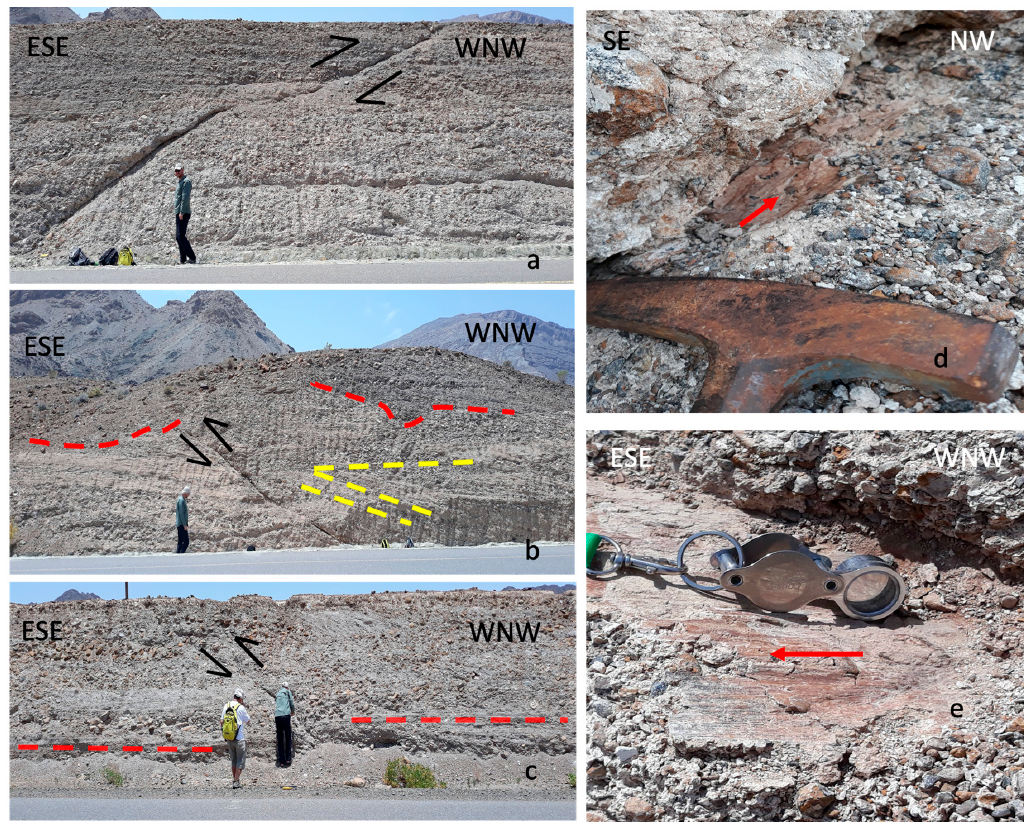
Figure 3. ( a ). Thrust in Quaternary deposits (fault 1), ( b ). Thrust and the two different conglomerates of the alluvial fan. The lower part is cemented and contains some cross bedding (yellow dashed lines). The upper conglomerate is unconsolidated. The contact of both conglomerates is marked by the red dashed line (fault 3), ( c ). 1-m-displacement of thrust 11. The red dashed line is a marker horizon, ( d ) and ( e ). Slickenside and slicken lines (faults 1, 3).